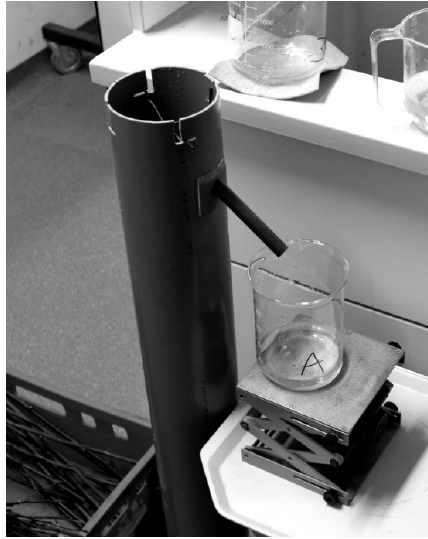
Figure 3. Medium-sized xylometer with a diameter of about 12 cm and overflow height of about 90